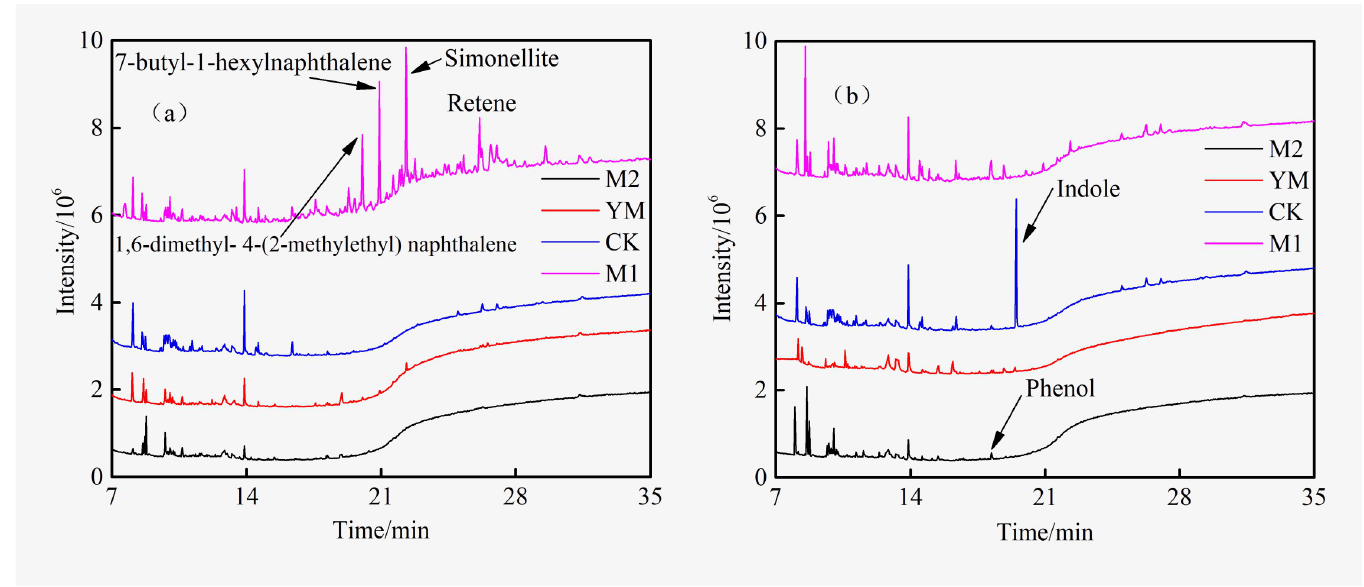
Fig 5. TIC of GC-MS of experimental groups before (a) and after (b) biogenic methane production.